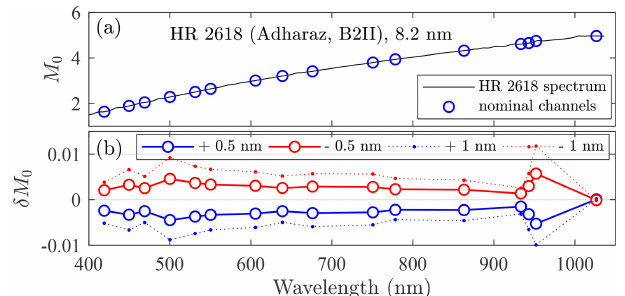
Figure 10. Bandwidth mismatch error for an (early-type) B-class star (Adharaz, HR 2618), as a consequence of a spectrum